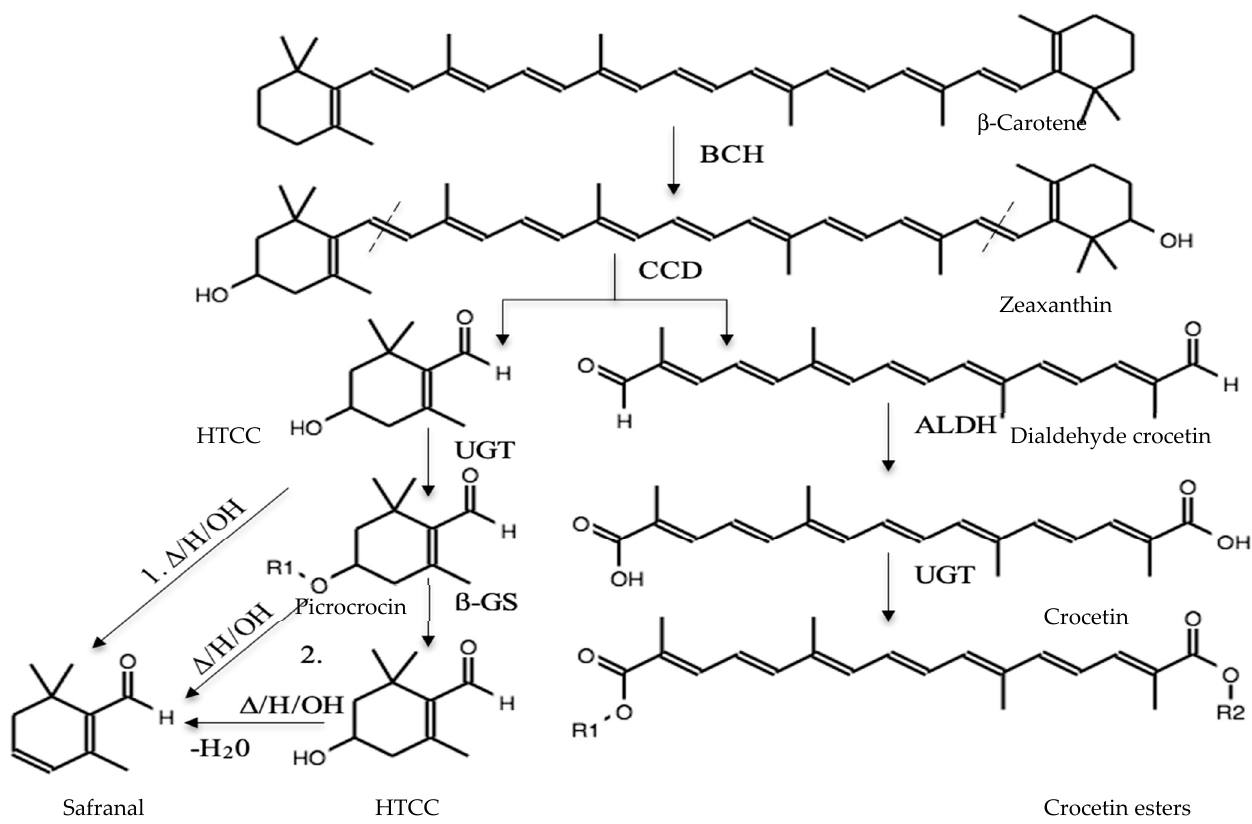
Figure 2. Enzymatic pathway in C. sativus and saffron chemical degradation of aromatic compounds from zeaxanthin.